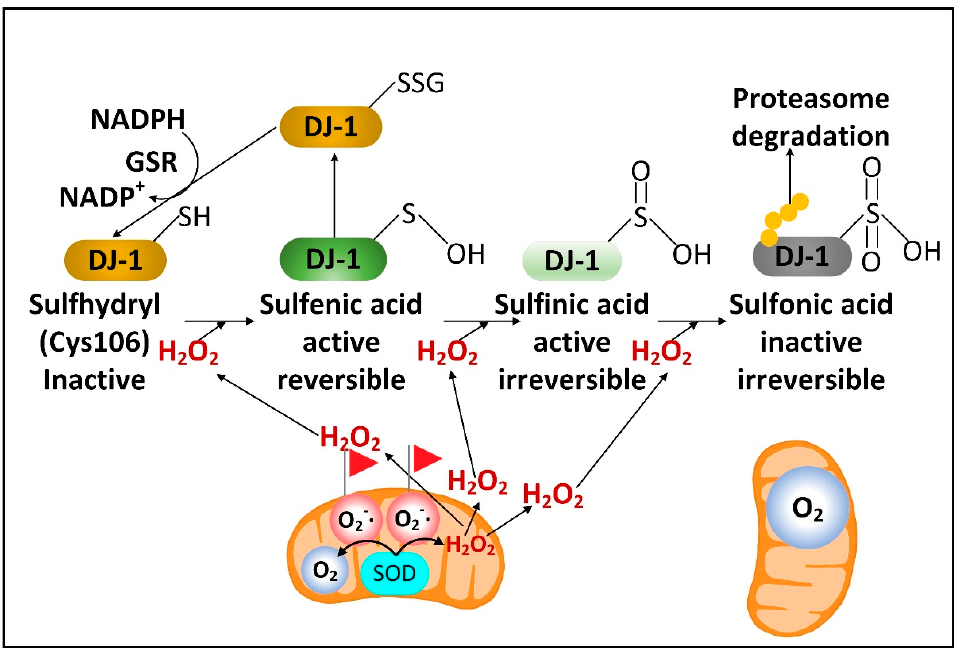
Figure 2. H 2 O 2 activates DJ ‐ 1. O 2• − released into the mitochondrial matrix space is converted into O 2 and H 2 O 2 by SOD2. Mitochondrial H 2 O 2 can be transported into the cytoplasm where moderate levels activate DJ ‐ 1, but high levels lead to DJ ‐ 1 inactivation and degradation.